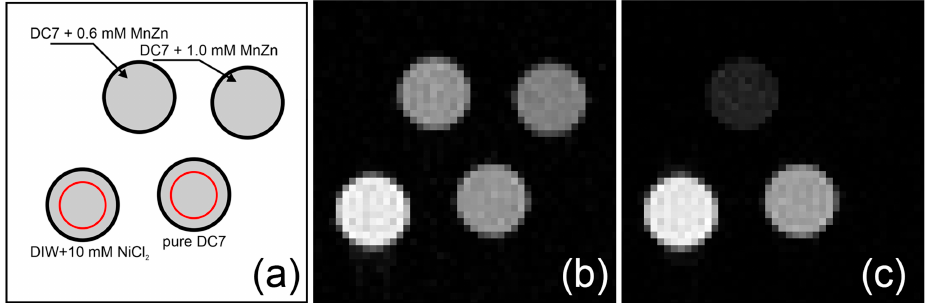
Figure 8. Cross-sectional MR images of the phantom at 3.0 T (18 °C). ( a ) Diagram showing the sample arrangement. Red circles denote the regions used to calculate the ratio between the intensity belonging to pure DC7 and deionized water doped with NCl 2 (10 mmol L − 1 ). ( b ) SEMS image, ( c ) GEMS image. For imaging parameters see the Methods section.